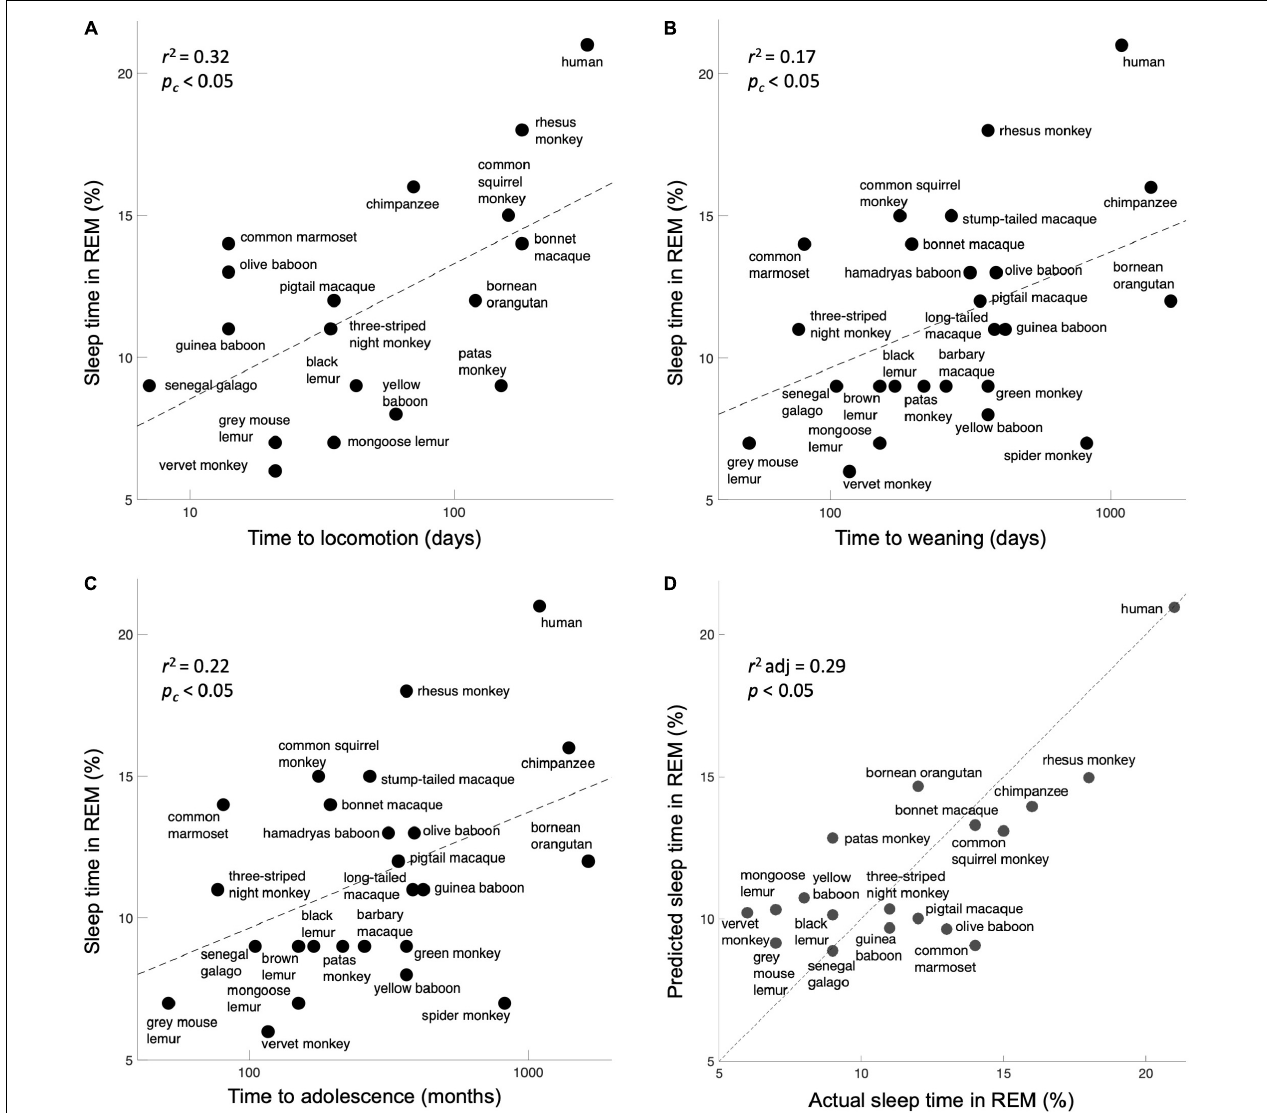
FIGURE 2 | Expressions of plasticity correlate with the percentage of sleep time spent in REM. (A) Time to locomotion. (B) Time to weaning. (C) Time to adolescence. Although these are crude correlates of neuroplasticity, they map significantly onto the fraction of REM sleep, as per the prediction. (D) A model incorporating all three behavioral measures of plasticity significantly predicts the percentage of sleep time spent in REM. The unity line signifies the perfect model